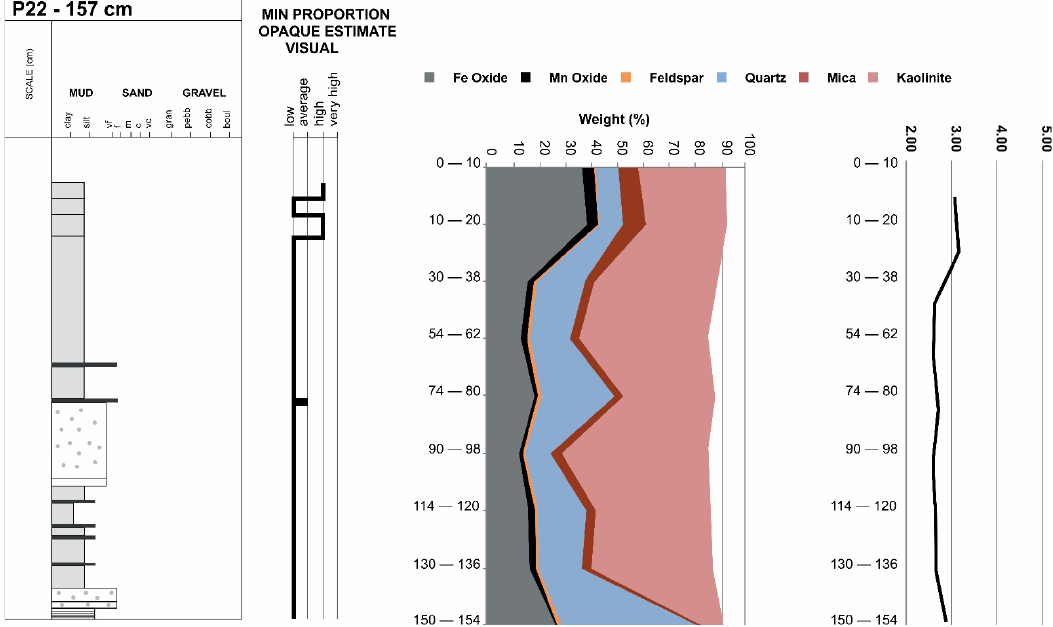
Figure 10. Multiproxy display of results obtained from P22 samples. From left to right one can ob- serve the log with textural description, opaque relative proportions, modal mineralogy and density. Sampled intervals are indicated by the horizontal axis on the last two charts.